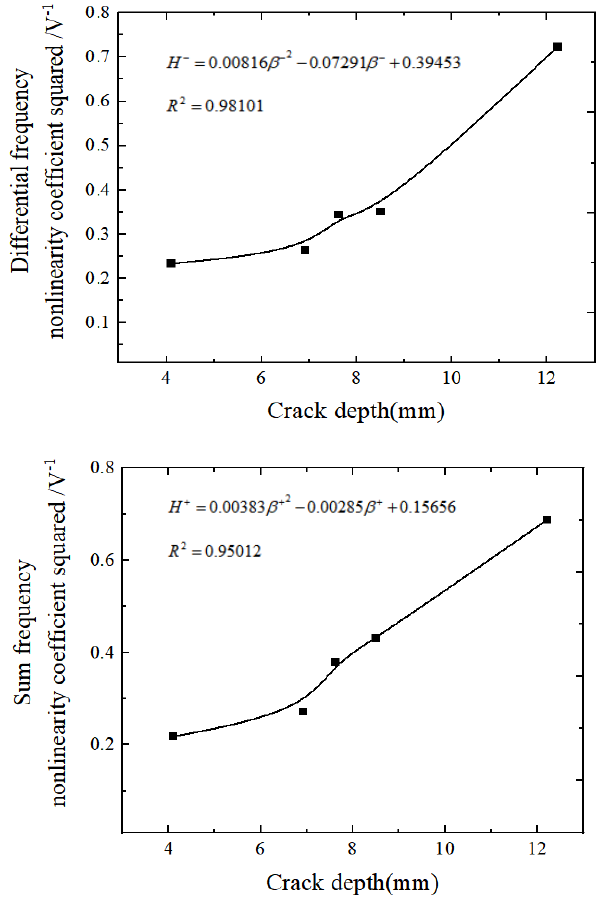
Figure 22. Nonlinear coefficient versus crack depth.